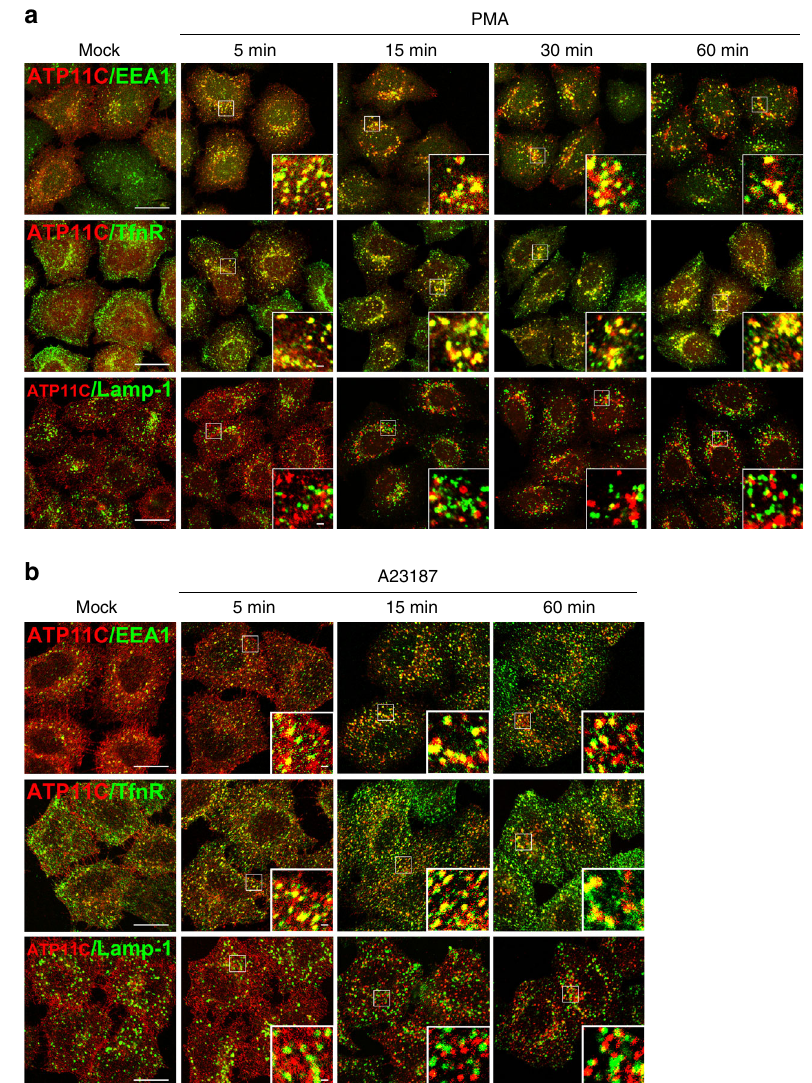
Fig. 3 Internalized ATP11C is not transported to late endosomes/lysosomes. a , b HeLa cells stably expressing C-terminally HA-tagged ATP11C was treated with vehicle alone for 60 min (Mock), 400 nM PMA (( a ) PMA), or 1 μ M A23187 in the presence of 1.8 mM CaCl 2 (( b ) A23187) for indicated times. The cells were fi xed and doubly stained for HA, and EEA1, TfnR, or Lamp-1, followed by incubation with Cy3-conjugated anti-rat and Alexa Fluor 488- conjugated anti-mouse secondary antibodies. Images were obtained by confocal microscopy. Scale bars, 20 μ m. Insets; bars, 1 μ